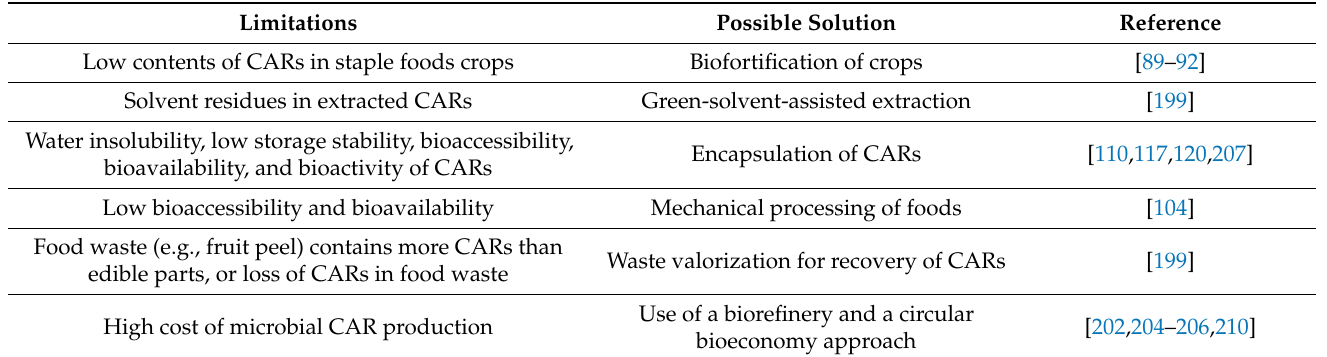
Table 1. The limitations associated with the use of CARs as functional food, and possible solutions to such